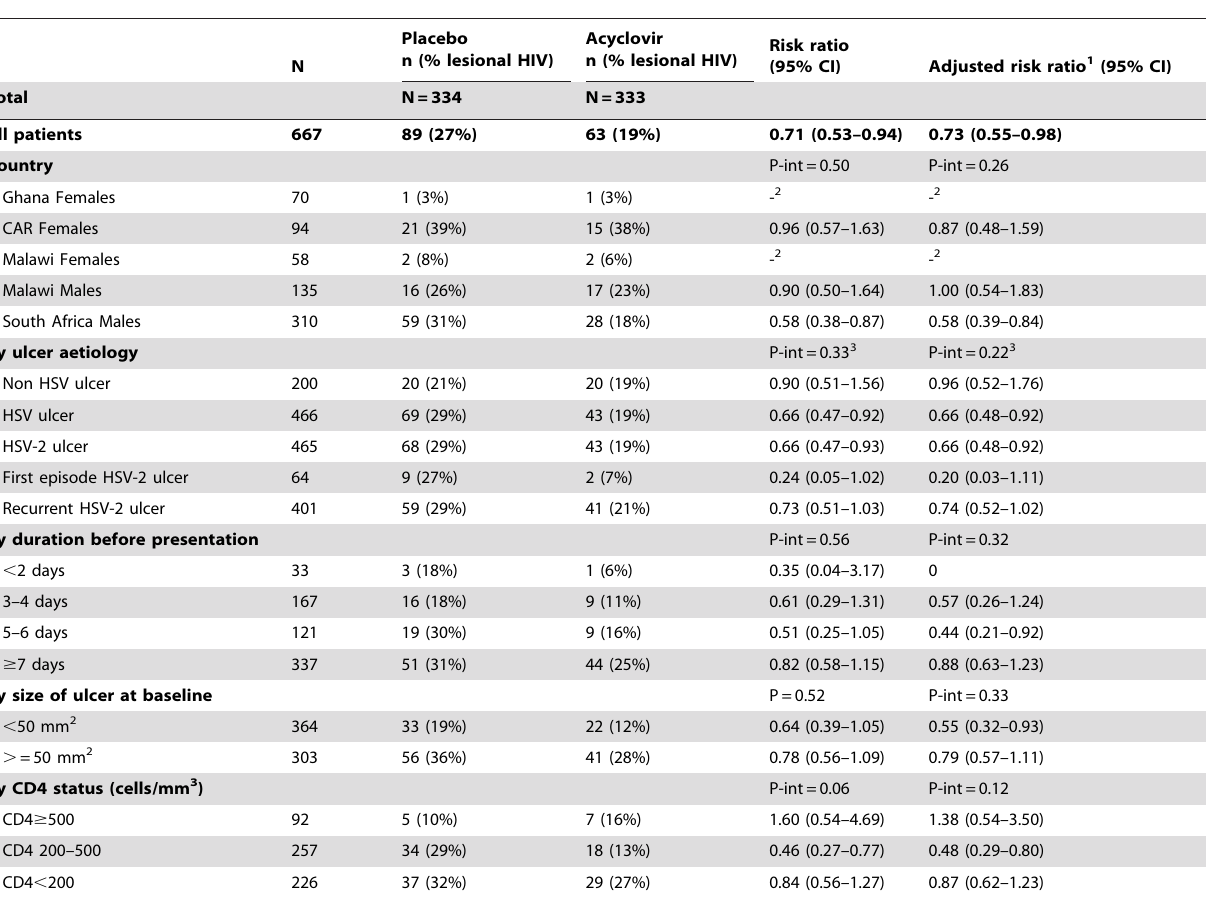
Table 5. Impact of acyclovir on lesional HIV-1 RNA on Day 7 among 667 HIV-1 seropositive trial